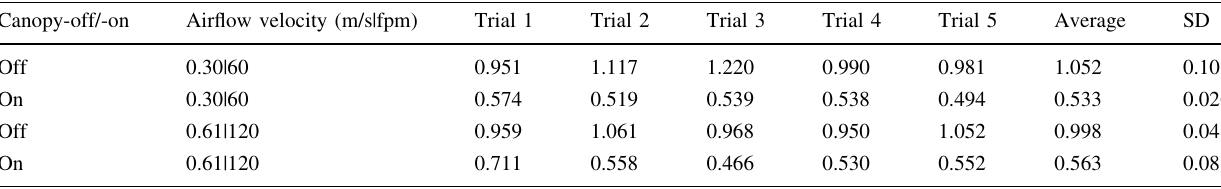
Table 10 Ratios calculated for the CAC at 10-in. height underneath the canopy using Large Fan #3 Canopy-off/-on